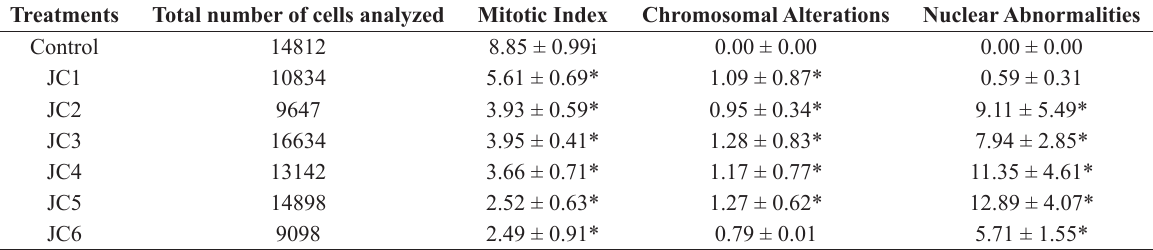
J. curcas oil effects on cell division in root tips of Lactuca sativa .